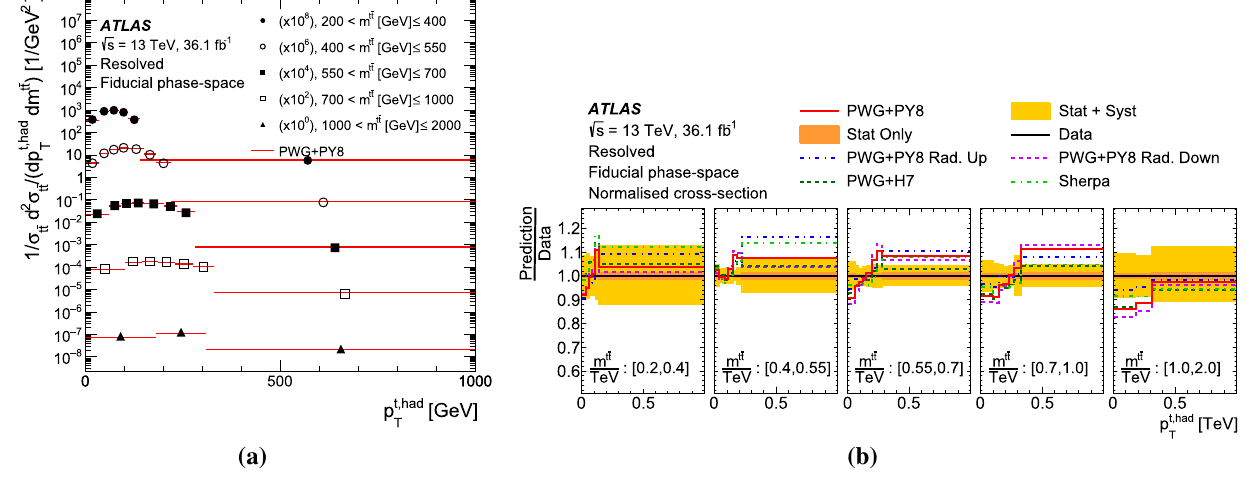
Fig. 26 a Particle-levelnormaliseddifferentialcross-sectionasafunc- tion of p t , had in bins of m t ¯ t in the resolved topology compared with the T prediction obtained with the Powheg + Pythia8 MC generator. Data